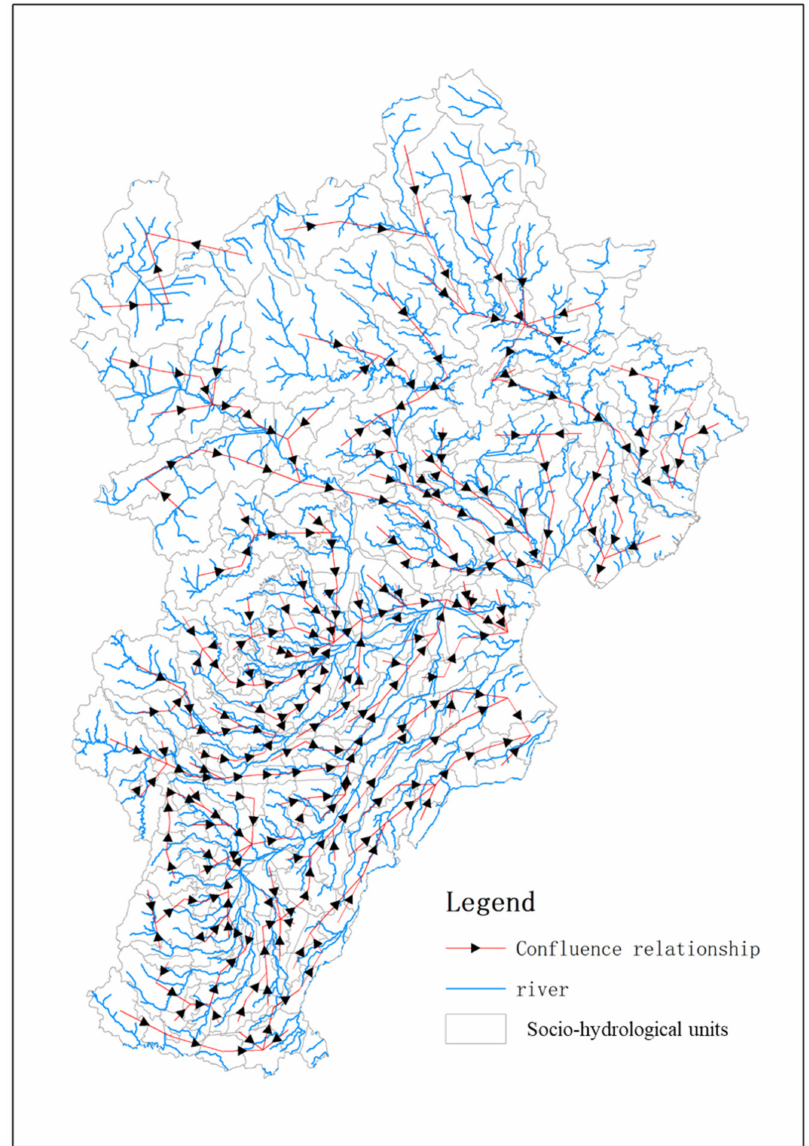
Figure 11. Generalized river network of study